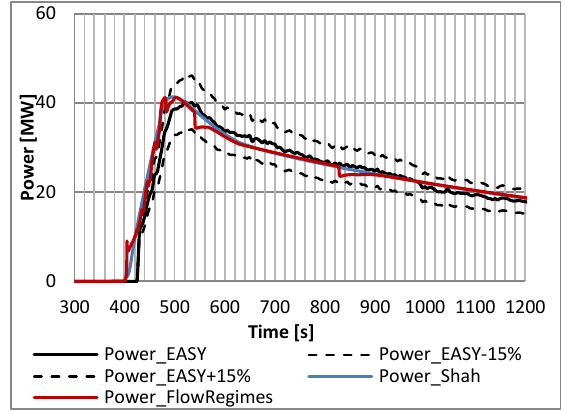
Fig. 6. Heat flow rates according to measurements and models.